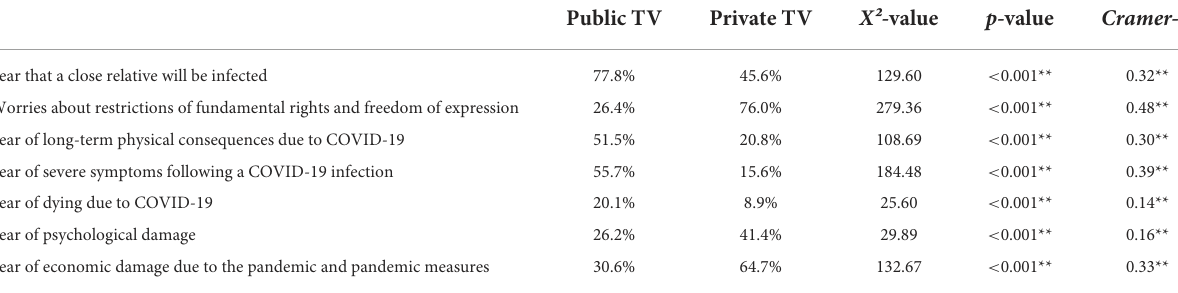
TABLE 2 Comparison of predominant fears in relation to media consumption: mainly public TV vs. also private TV